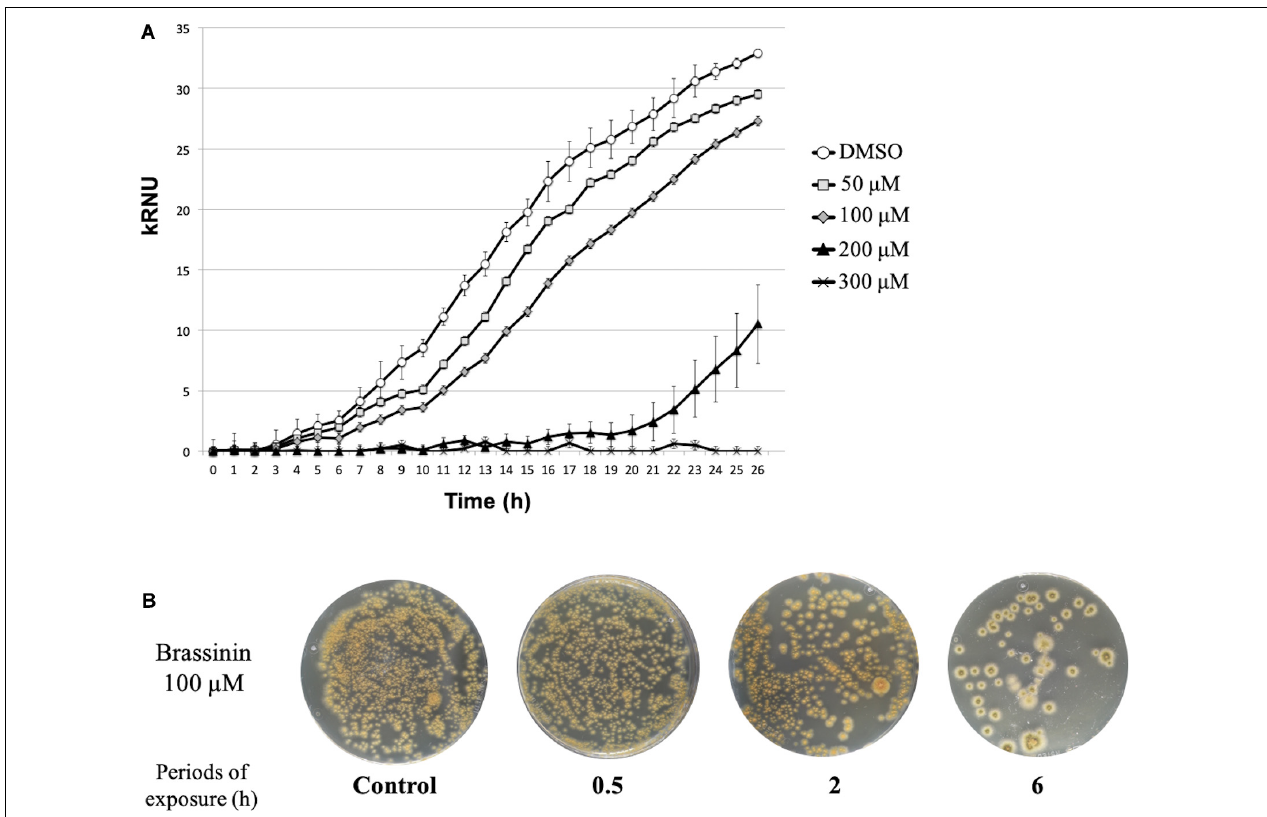
FIGURE 1 | Susceptibility of A. brassicicola to brassinin. (A) Growth of the wild-type strain for 33 h at 24 ◦ C. The unit of the Y -axis corresponds to the relative nephelometric unit (RNU). Microplate wells containing standard PDB medium supplemented either with DMSO or various concentrations of brassinin were inoculated with a wild-type conidial suspension (10 5 conidia/mL, final concentration). Fungal growth was recorded using a nephelometric reader. Each condition was conducted in triplicate and the experiments were repeated twice. Areas under the growth curves were used to calculate MGI 50 , i.e., the phytoalexin concentration for which 50% of mycelium growth inhibition was observed. (B) Effect of brassinin (100 µ M) on viability of germinated A. brassicicola conidia. Conidia (10 5 mL - 1 ) were germinated for 24 h, incubated in PDB for various times in the presence of brassinin at the desired concentration. After centrifugation, the pellets containing the germinated conidia were re-suspended in 200 µ L, which were applied on the Petri dishes containing PDA medium. Colonies were visualized after 48 h of incubation. Control plates were prepared with conidia incubated for up to 24 h with DMSO (1% v/v final